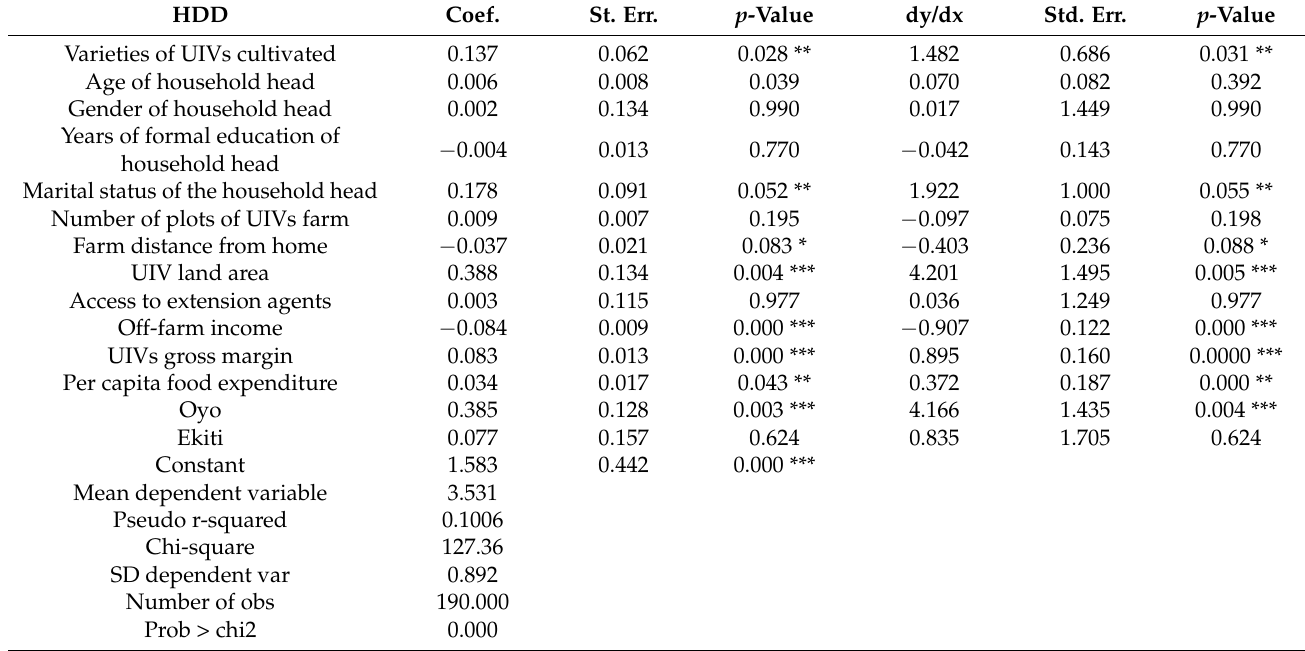
Table 4. Effect of UIVs cultivation on household food security: negative binomial